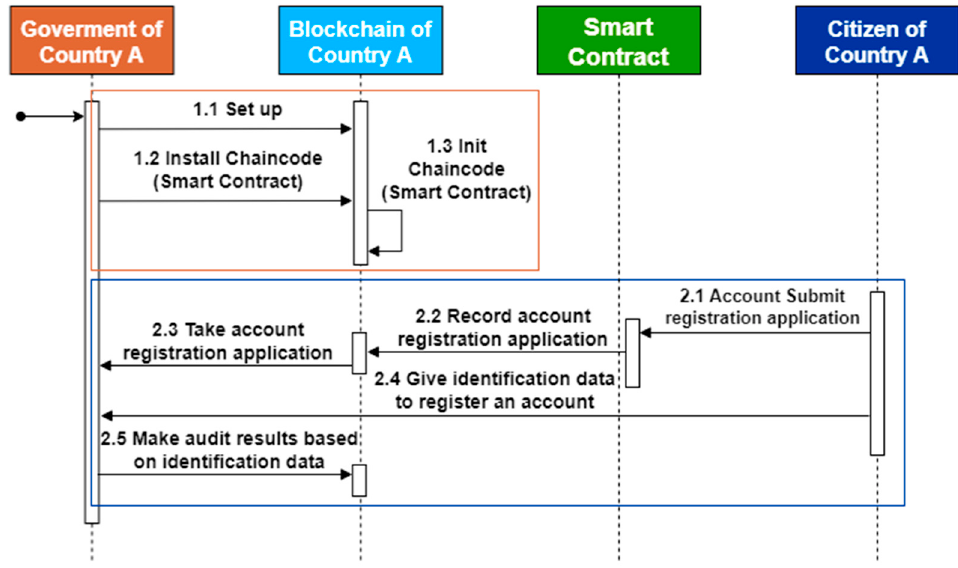
Figure 10. System setup and user registration diagram.